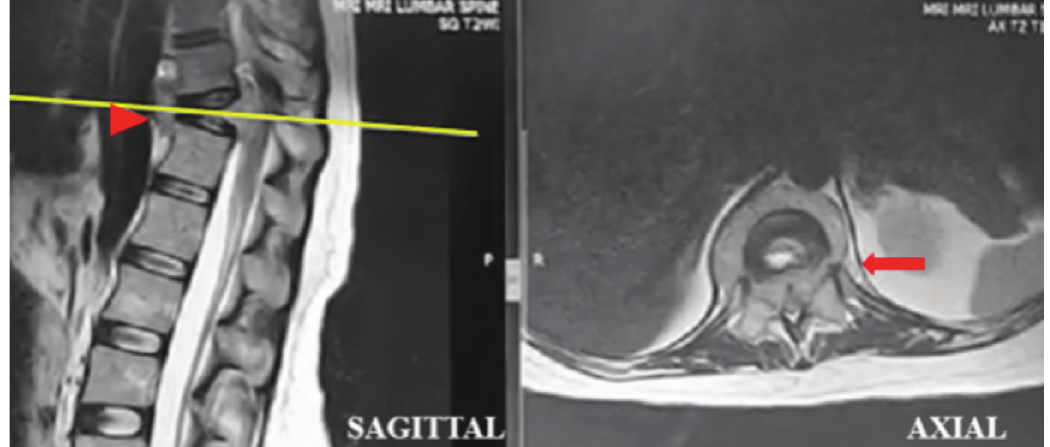
Fig. 1: Magnetic resonance imaging (MRI) of the patient’s spine. Arrowhead shows T11 vertebra plana with kyphotic deformity. Arrow demonstrates paravertebral soft tissue mass formation extending into spinal canal causing spinal canal stenosis and cord compression.